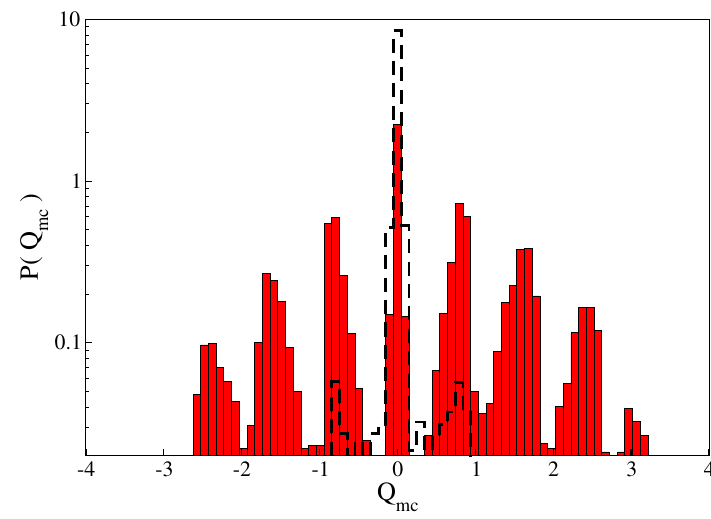
Figure 6 . Probability distribution of the topological charge Q mc , measured after 20 stout smearing steps with (cid:26) st = 0 : 1, for the same run parameters and the same bias potential relative to (cid:12)gure 5. As a reference, we also show (dashed line) the probability distribution obtained with the same bare parameters at zero bias potential, which has been already reported in (cid:12)gure